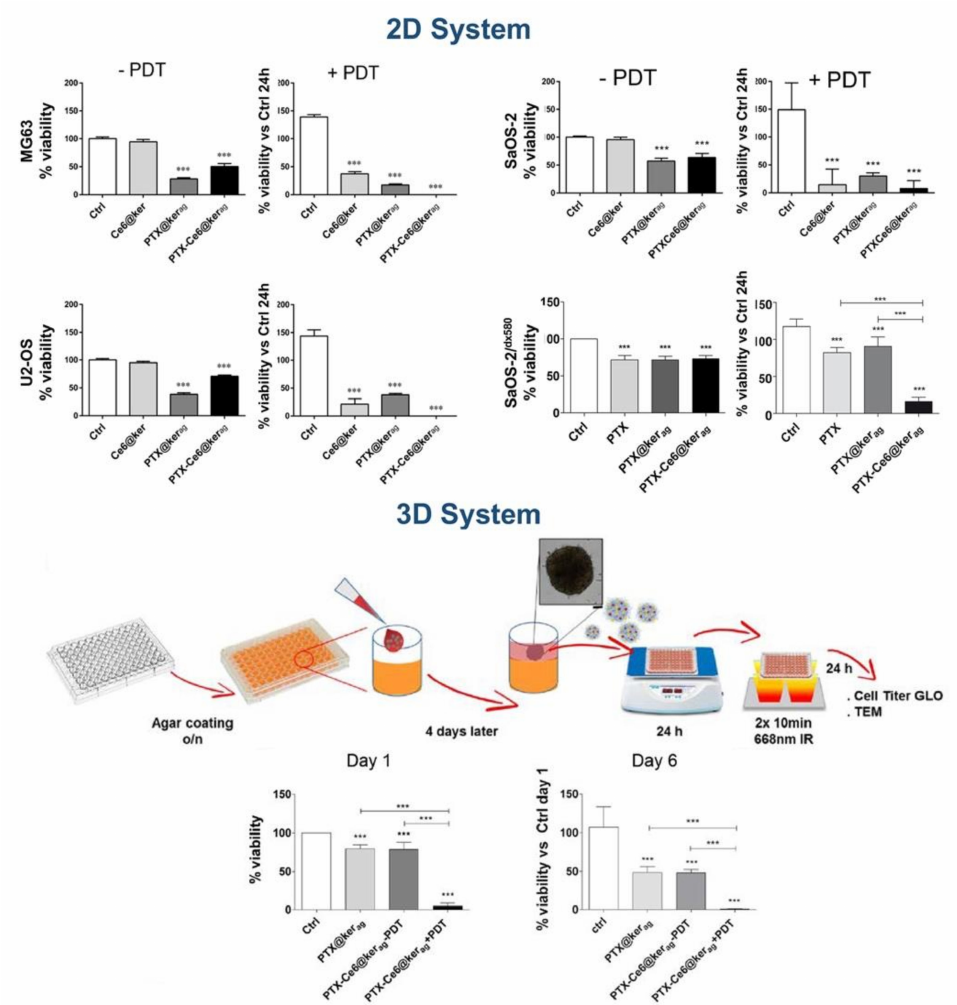
Figure 9. Impact of PTX-Ce6@kerag on 2D and 3D OS tumor model. Reprinted under Creative Common CC BY license from [18]. *** p <